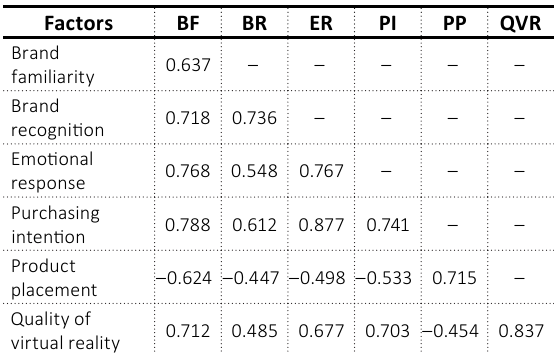
Table 2. Discriminant validity-HTMT ratio